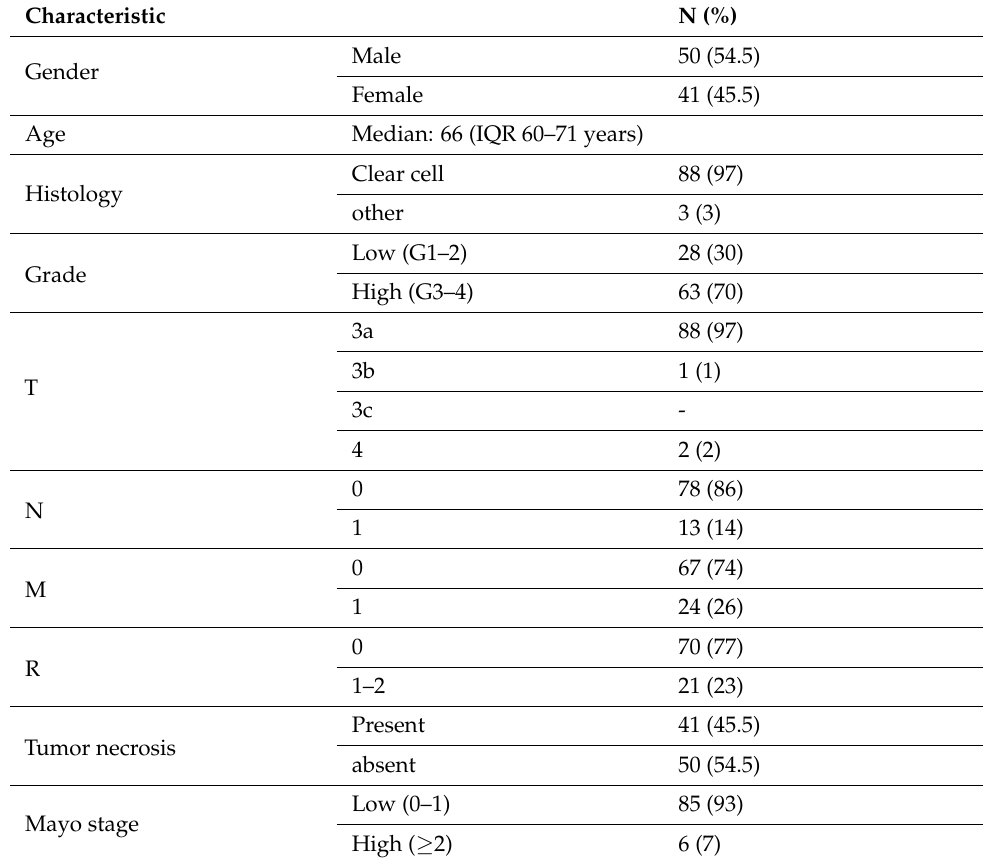
Table 1. Basic characteristics of the study group. Abbreviations: LMR: lymphocyte to monocyte ratio; NLR: neutrophil to lymphocyte ratio; PLR: platelet to lymphocyte ratio; IQR interquartile